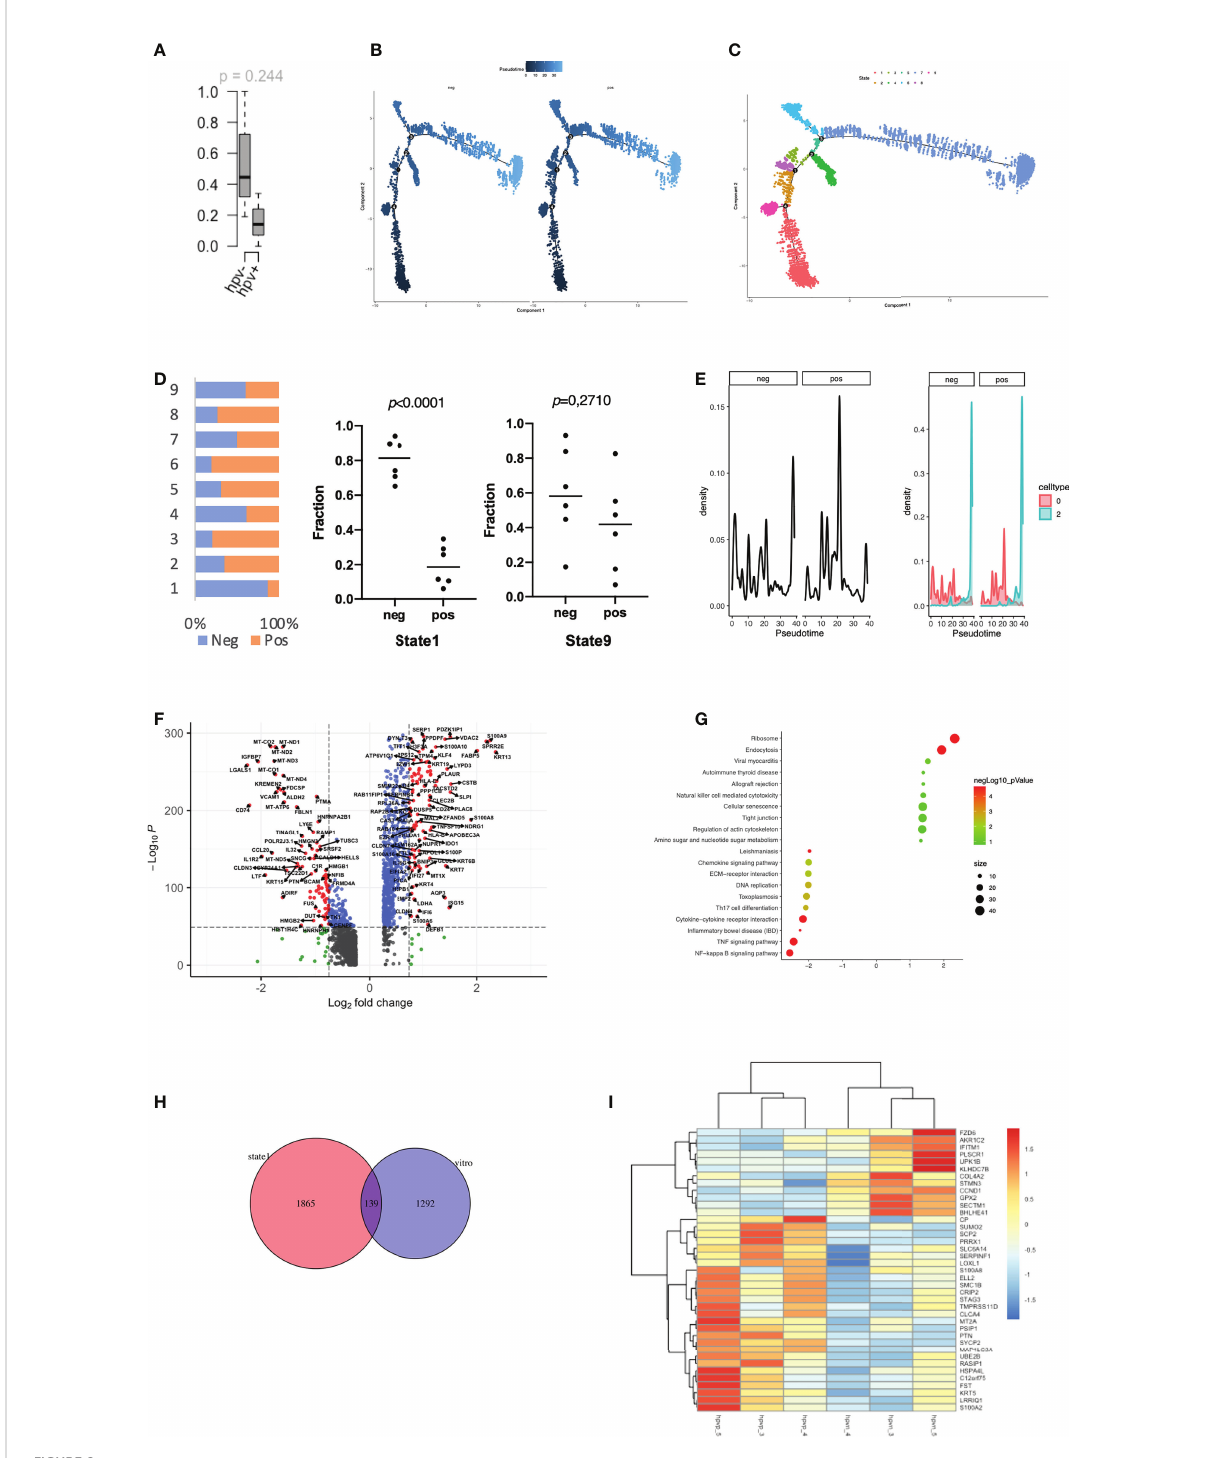
FIGURE 2 Stemness of HPV-infected tumour cells. (A) Boxplots to show the mRNAsi in the HPV + or HPV - cell lines (n=3). (B) Pseudotime of HPV + and HPV - tumour cells. (C) Trajectory analysis of HPV + and HPV - tumour cells after identi fi cation of 9 states. (D) The bar chart indicates the ratio of HPV + and HPV - tumour cells in different trajectory states. (E) Ridge plots showing the distribution of HPV + and HPV - tumour cells on the pseudo-time. (F) A volcano plot showing the DEGs of state 1 tumour cells and their related functions. (G) A bubble plot showing the DEGs of state 1 tumour cells and their related functions. (H) A Venn diagram showing the overlapping number of DEGs from the state 1 tumour cells and the HPV + cell lines. (I) A heatmap showing the expression of the overlapped DEGs in the HPV + and HPV - cell